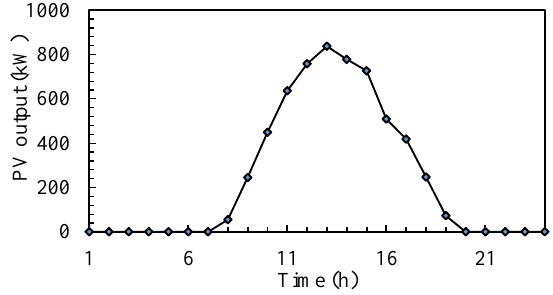
Figure 5. Hourly PV power production by DG 3 .